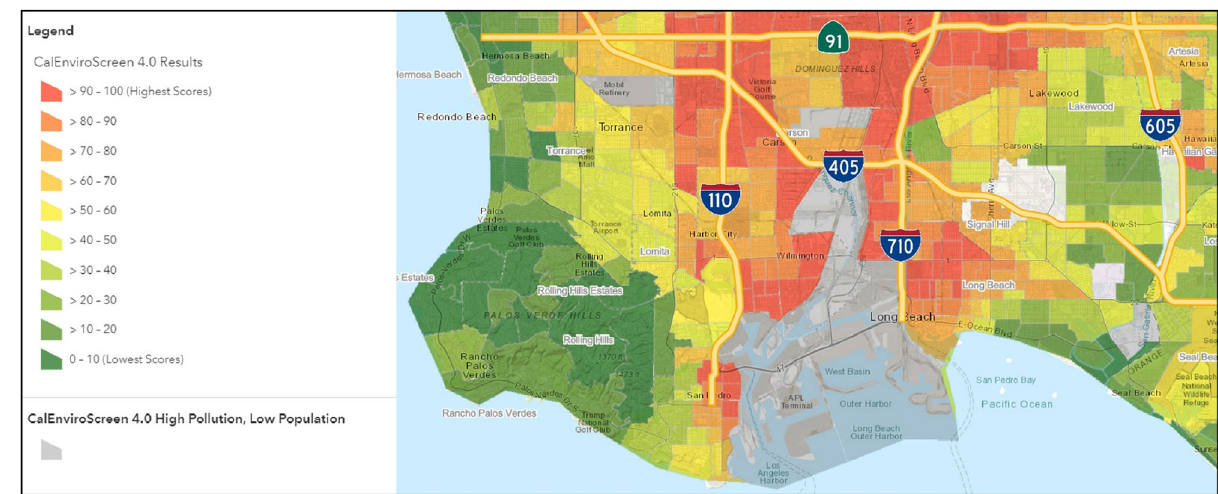
Fig. 1 The modeling domain. Image source https://oehha.ca.gov/calenviroscreen/report/calenviroscreen-40. On this fi gure, the I-710 freeway runs north to south just west of the Lakewood, Signal Hill, and Long Beach communities; it then joins Highway 47 and turns west (towards the area marked Rolling Hills). Permission to use this map was granted by the Of fi ce of California Environmental Health and Hazard Assessment. Table 1 EV penetration